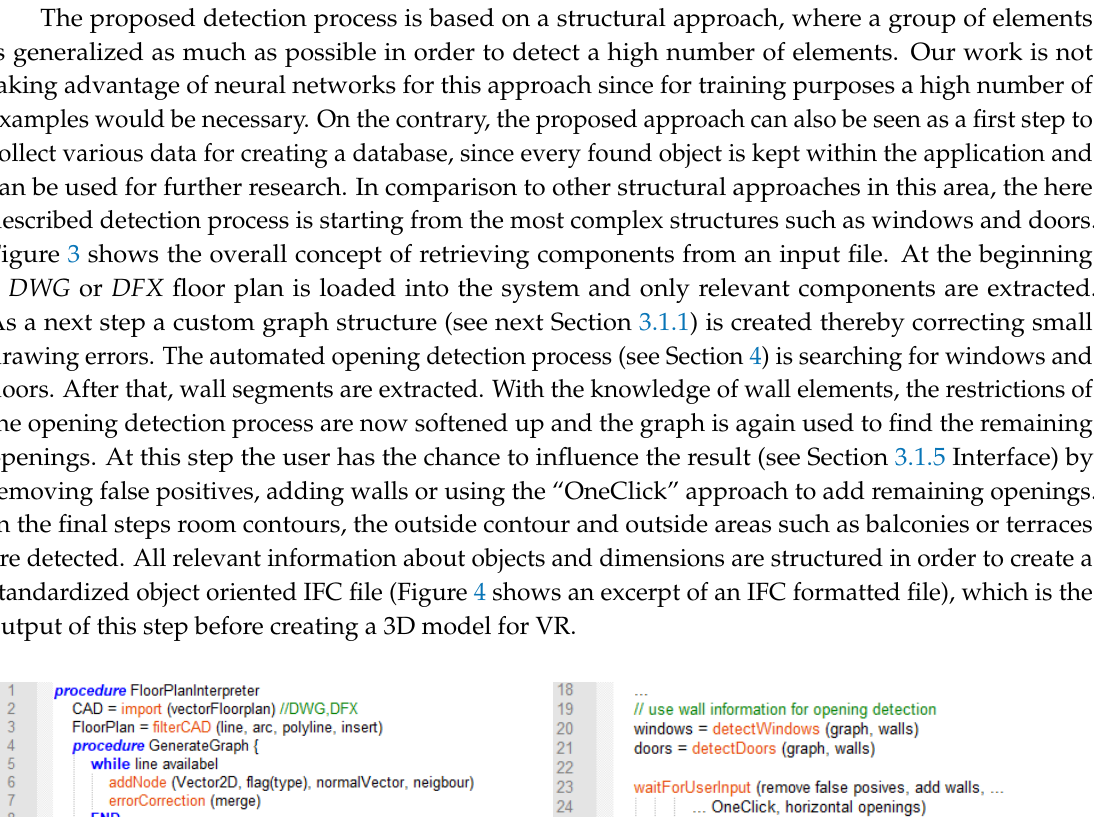
Figure 4. Excerpt of interesting entries of an Industry Foundation Classes (ICF) formatted file (ISO 10303-21).